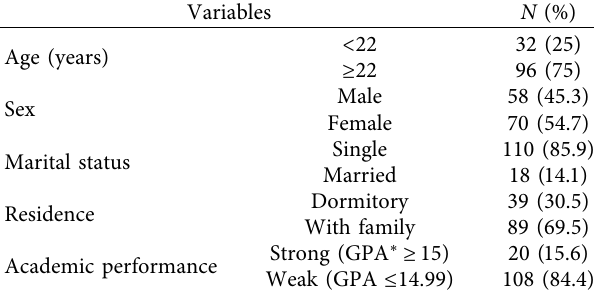
Table 1: Demographic characteristics of the students ( N �